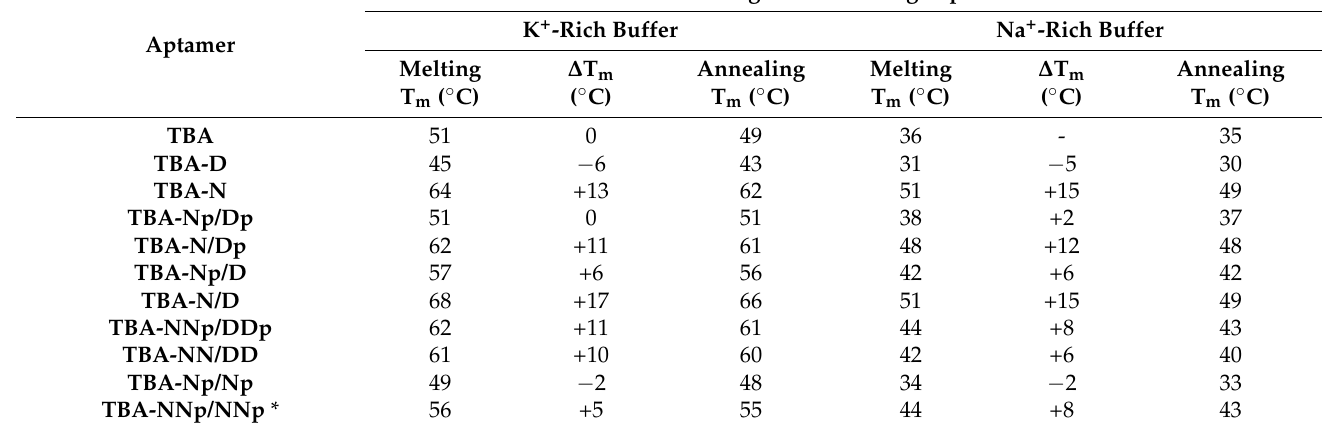
Table 1. Apparent melting temperature values obtained by CD-monitored thermal experiments for heating and cooling profiles of the studied oligonucleotides in the selected K + -rich and Na + -rich buffer solutions. Apparent T m values were estimated from the maxima of the first derivative plots. Each T m value was calculated as the average of three independent measurements. The error associated with the T m determination was ± 1 ◦ C. ∆ T m was calculated by subtracting the measured T m of unmodified TBA from that observed for each TBA analogue. * Followed at 268 nm.